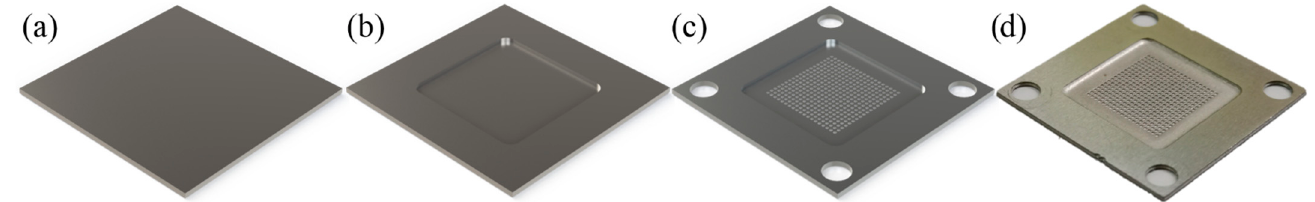
Figure 8. Schematic outline of the steps performed to fabricate a unibody extractor, the ( a ) substrate are processed for ( b ) the first process, and ( c ) the schematic outline and the ( d ) image after the second processing.